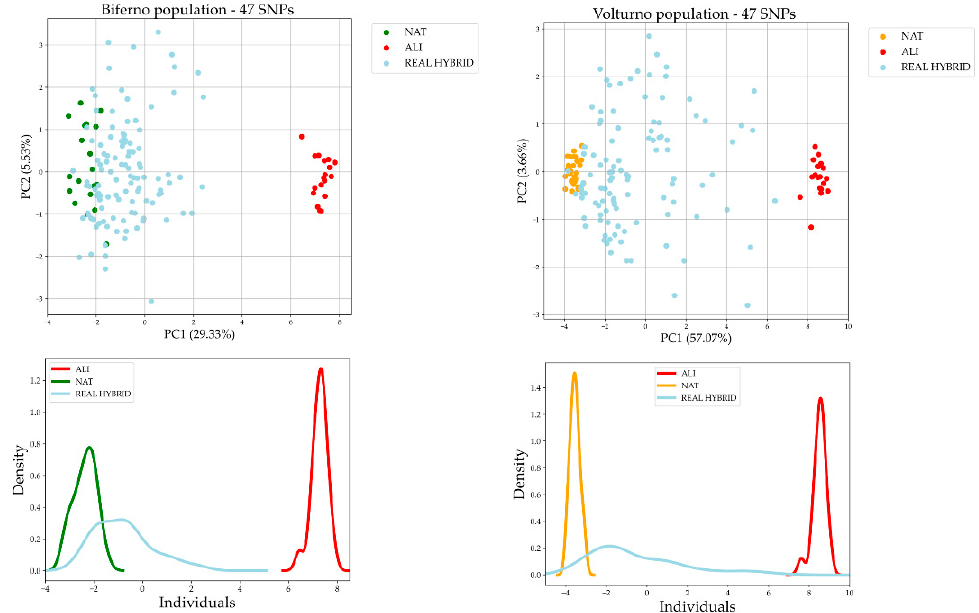
Figure 2. PCA and density distribution of the PC1 obtained using the common 47 AIMs on reference populations and real hybrid dataset split by rivers.